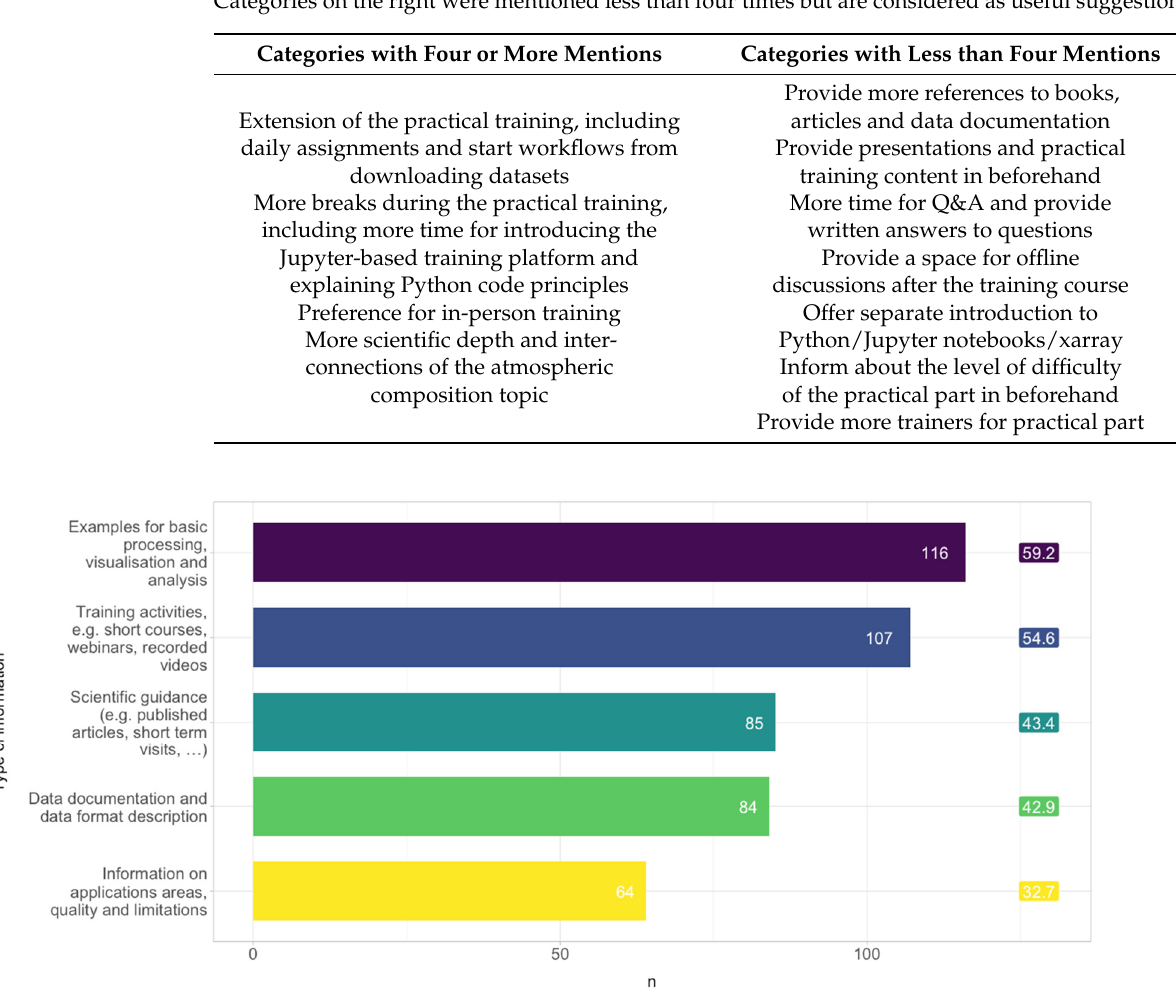
Figure A2 . Responses to the question ‘What type of information would help you in using a specific dataset?’ ( n = 196). Bars indicate absolute numbers, labels on the right indicate relative frequencies in %.